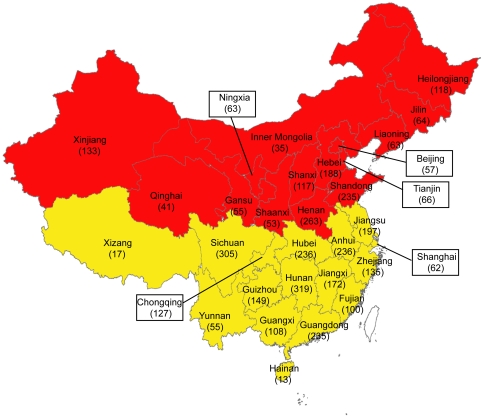
Distribution map of M. tuberculosis isolates included in this study.The provinces colored with red represent the northern region of China including Heilongjiang, Jilin, Liaoning, Inner Mongolia, Hebei, Beijing, Tianjin, Shandong, Henan, Shanxi, Shaanxi, Ningxia, Gansu, Qinghai and Xinjiang. And the provinces colored with yellow represent the southern region of China including Jiangsu, Anhui, Hunan, Sichuan, Yunnan, Guizhou, Guangdong, Guangxi, Fujian, Jiangxi, Zhejiang, Hainan, Xizang, Shanghai and Chongqing.